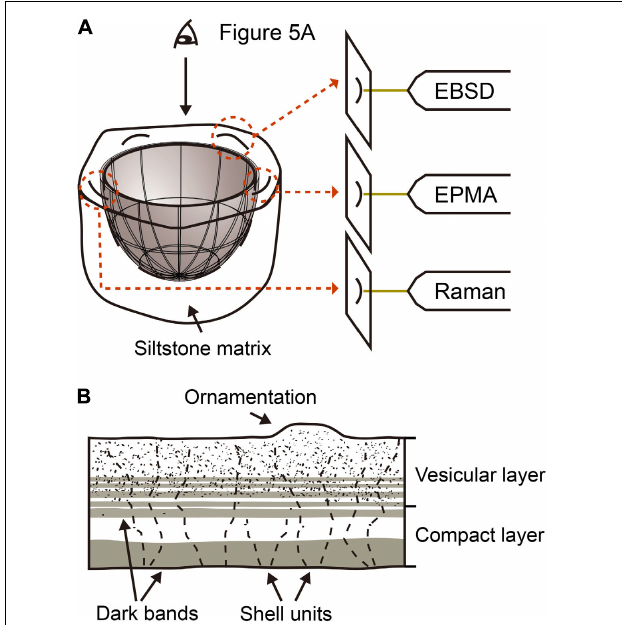
FIGURE 3 | Schematic view of study methods and eggshell microstructure. (A) The material excavated from the field is composed of partially preserved egg and nearby fragments. After confirming the consistent microstructure between the holotype and nearby fragments, the fragments were prepared for physico-chemical analyses. See also Supplementary Figure S1 . (B) A schematic view and terminologies of microstructural features observed in both holotype egg and nearby fragments. See text for